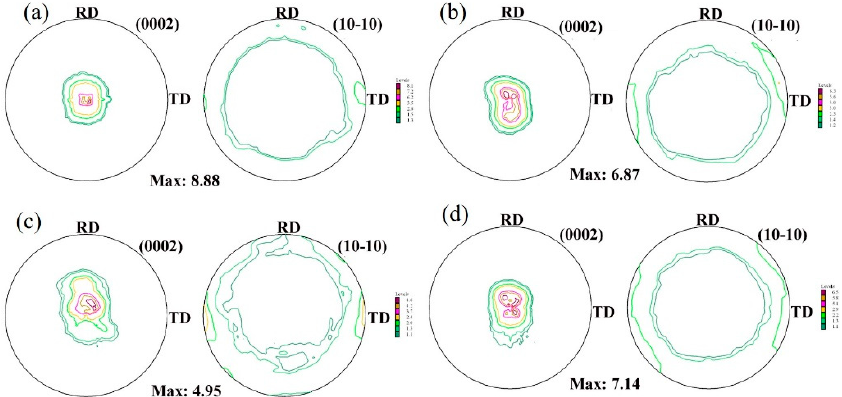
__ Figure 6. The (0002) and (1010) pole figures of the rolled AZ80 magnesium alloys pre-aged for: ( a ) 75; ( b ) 160; ( c ) 200 and ( d ) 240 min .